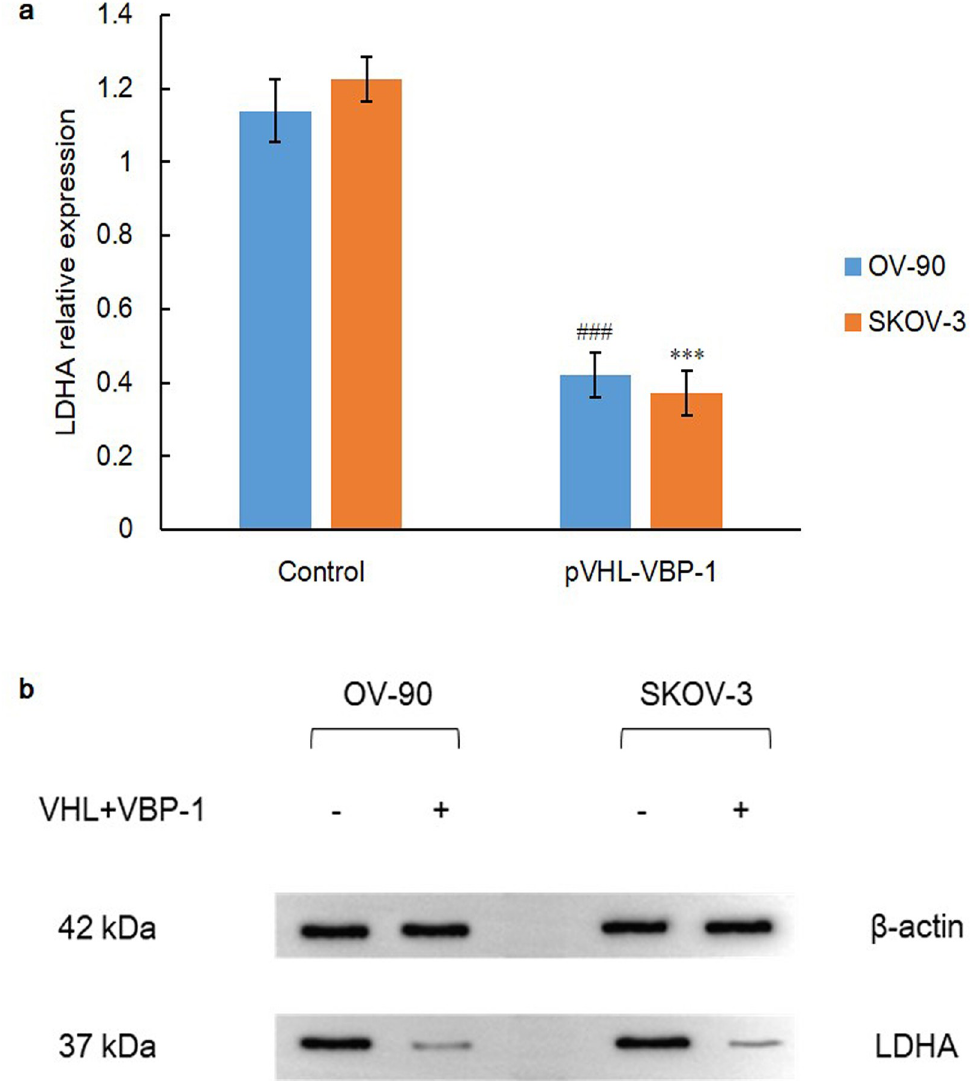
Fig 10. LDHA expression after plasmids transfection for 48 h. A) Over-expression of pVHL-VBP-1 inhibits protein expression of LDHA in OV-90 and SKOV-3 ovarian cancer cell lines. Data are shown as mean ± SD of at least three individual experiments. ( � P < 0.05, �� P < 0.01, ��� P < 0.001 vs. SKOV-3 control; # P < 0.05, ## P < 0.01, ### P < 0.001 vs. OV-90 control). B) The expression of LDHA was assessed by western blot analysis after transfection of plasmids of VHL and VBP-1 for 48 h. The equal protein loading is shown by detection of β -actin. The figures show representative blots which were cropped from original images.